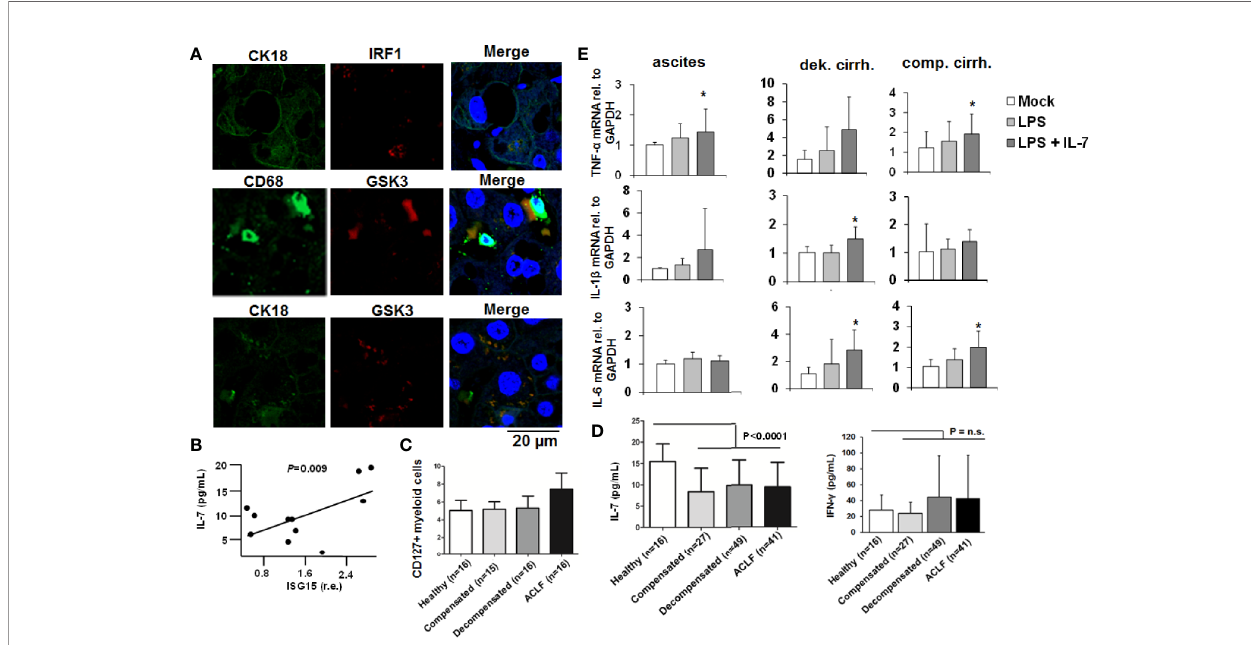
FIGURE 8 | The IFN-IRF-1-IL-7 axis is present in patients with liver cirrhosis. (A) Presence of the proteins interferon-response factor-1 (IRF1), Glycogen synthase kinase-3 (GSK3), CD68 as a macrophage marker, and CK18 as part of the hepatocellular cytoskeleton was analyzed by immuno fl uorescence in paraf fi n-embedded tissue of a representative patient with liver cirrhosis. One out of two experiments (n=2) is shown as demonstration. (B) Interferon-stimulated gene (ISG)-15 relative to GAPDH mRNA concentration was quanti fi ed by quantitative PCR in (PBMCs of 11 randomly selected patients with liver cirrhosis from (C) and correlated with serum concentrations of interleukin-7 (IL-7). P value for Pearson correlation. (C) Flow cytometric analyses of the percentage of CD127 positive myeloid cells relative to all myeloid cells from patients with liver cirrhosis and available PBMCs or healthy controls. (D) Serum concentrations of IL-7 and interferon-(IFN)- g in healthy controls and in patients with different liver cirrhosis stages or with acute-on-chronic liver failure (ACLF) were determined by ELISA. P for comparison between healthy controls and all patients with liver cirrhosis. (E) Monocytes from peripheral blood and ascites-derived macrophages of patients with ascites (n=4), compensated liver cirrhosis (n=4) and decompensated liver cirrhosis (n=4, all measured in duplicate) were stimulated ex vivo with 10 ng/ml IL-7 and/or 10 ng/ml LPS, as indicated, for 6 h. Then, quantitative analysis of mRNA of IL-1 b , IL-6, and tumor necrosis factor a (TNF a ) levels relative to housekeeping GAPDH mRNA was performed. * P < 0.05 for comparison of the indicated condition versus mock; other comparisons were not signi fi IL-7 that might cause less ef fi cient T cell immune responses compared to conventional therapies with pegylated IFN- a .